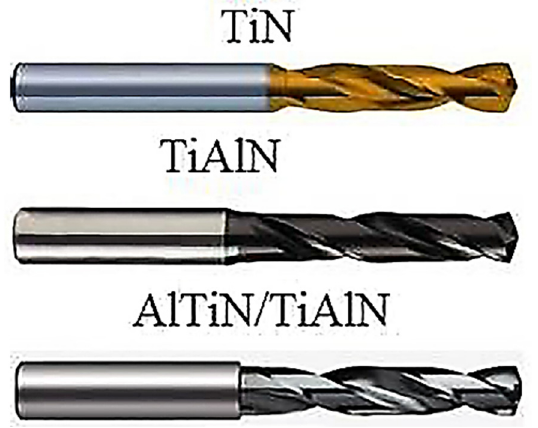
Figure 14. Drilling tools with different coatings (adapted from [87]) .